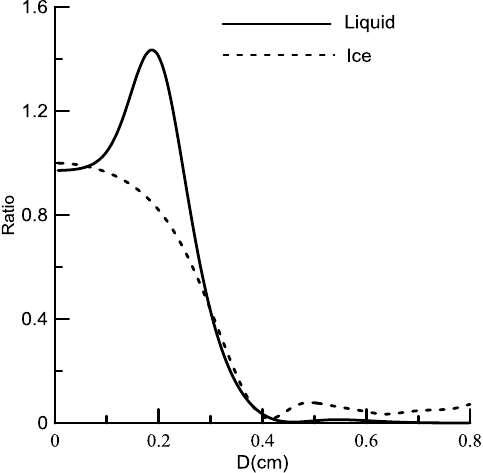
Figure 20. Ratios of corrected backscattering cross sections of raindrops and ice spheres with Ka and C bands (Ka/C).